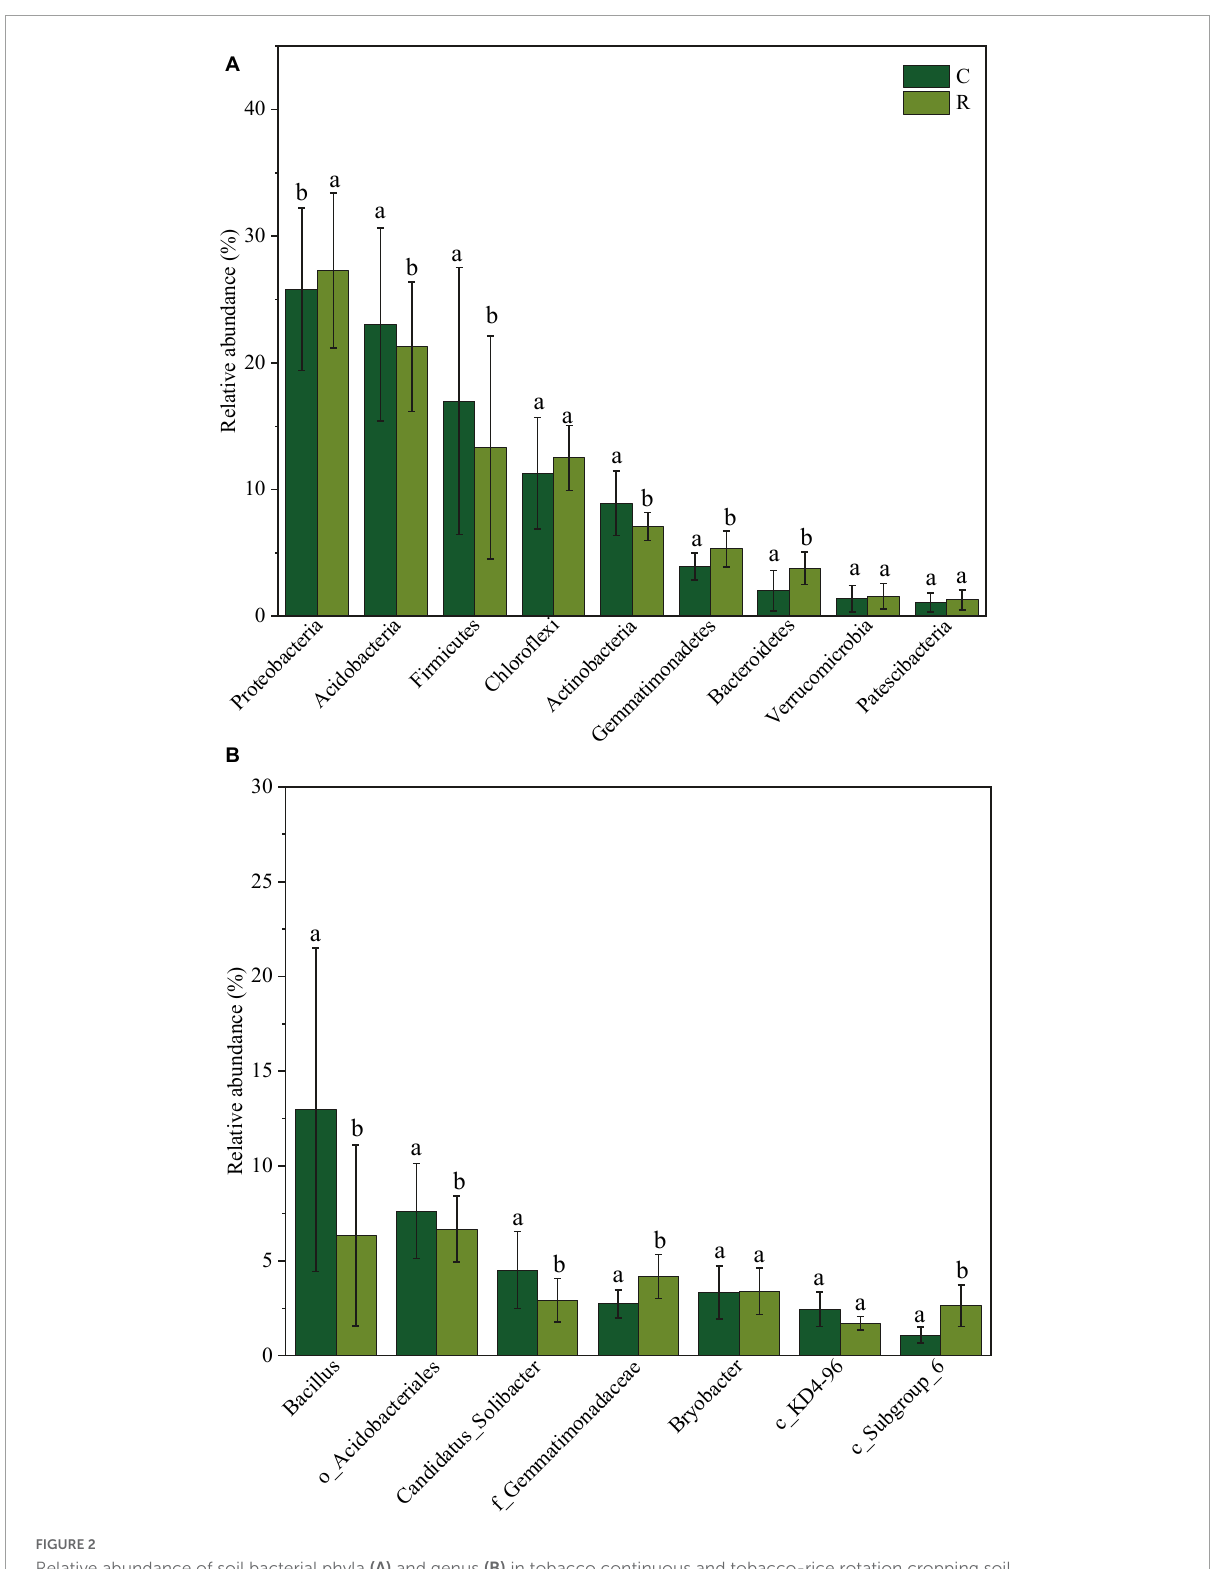
FIGURE2 Relative abundance of soil bacterial phyla (A) and genus (B) in tobacco continuous and tobacco-rice rotation cropping